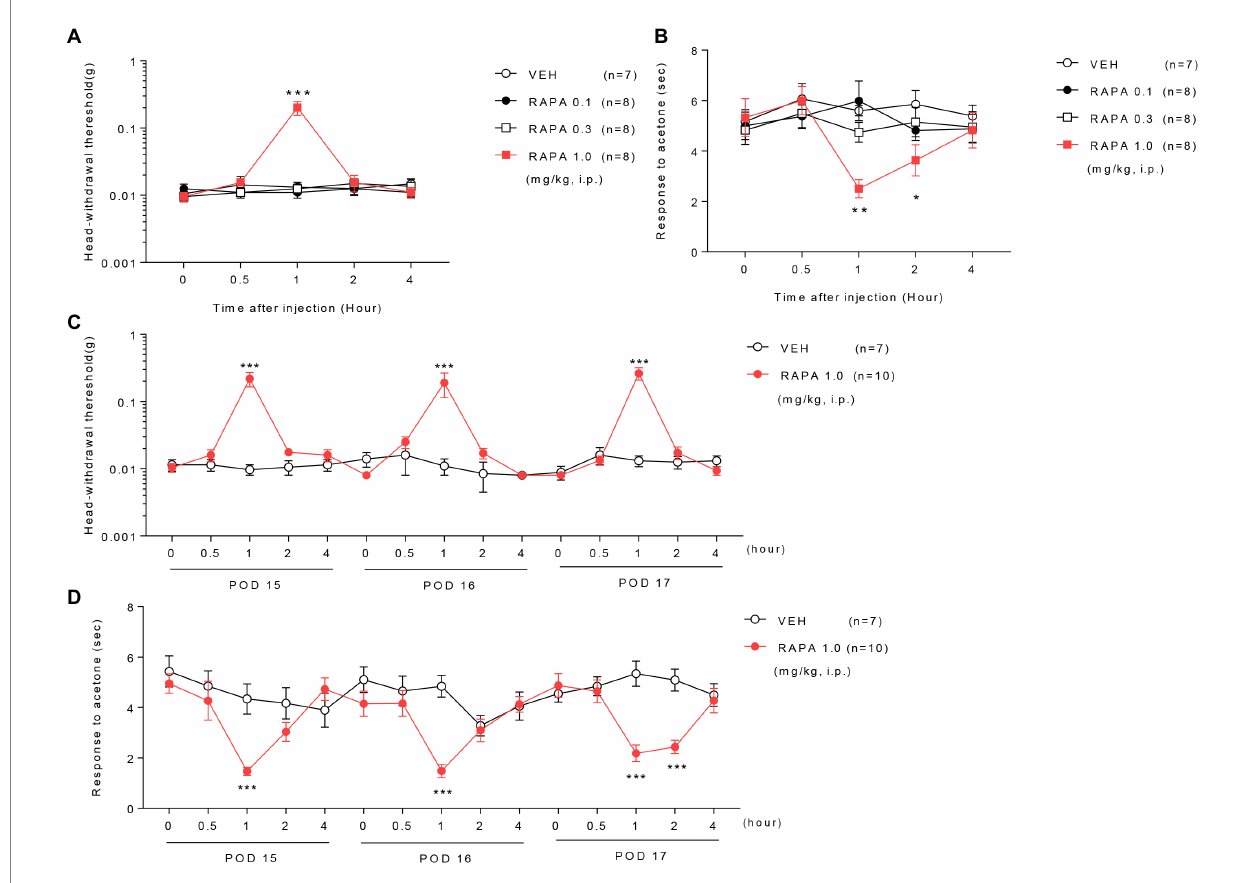
FIGURE 2 Effect of rapamycin on mechanical and cold allodynia in infraorbital nerve-injured mice. Low or medium doses of rapamycin (RAPA, 0.1 or 0.3 mg/kg) did not relieve mechanical and cold allodynia, whereas high-dose rapamycin (1 mg/kg) significantly ameliorated both mechanical (A) and cold allodynia (B) 1–2 h after injection compared with those in the vehicle (VEH)-treated group on postoperative day (POD) 14 in ION-pNL mice (A,B) . * p < 0.05, ** p < 0.01, *** p < 0.001 as compared with the VEH group, n = 7–8 per group. Daily treatments with high-dose rapamycin for 3 days (POD 15–17) produced a transient antiallodynic effect in both mechanical and cold allodynia tests, whereas both the maximal effect at 1 h post injection each day and basal response values before the next injection were unchanged (C,D) . * p < 0.05, ** p < 0.01, *** p < 0.001 as compared with the VEH group, n = 7 for RAPA group and n = 10 for VEH